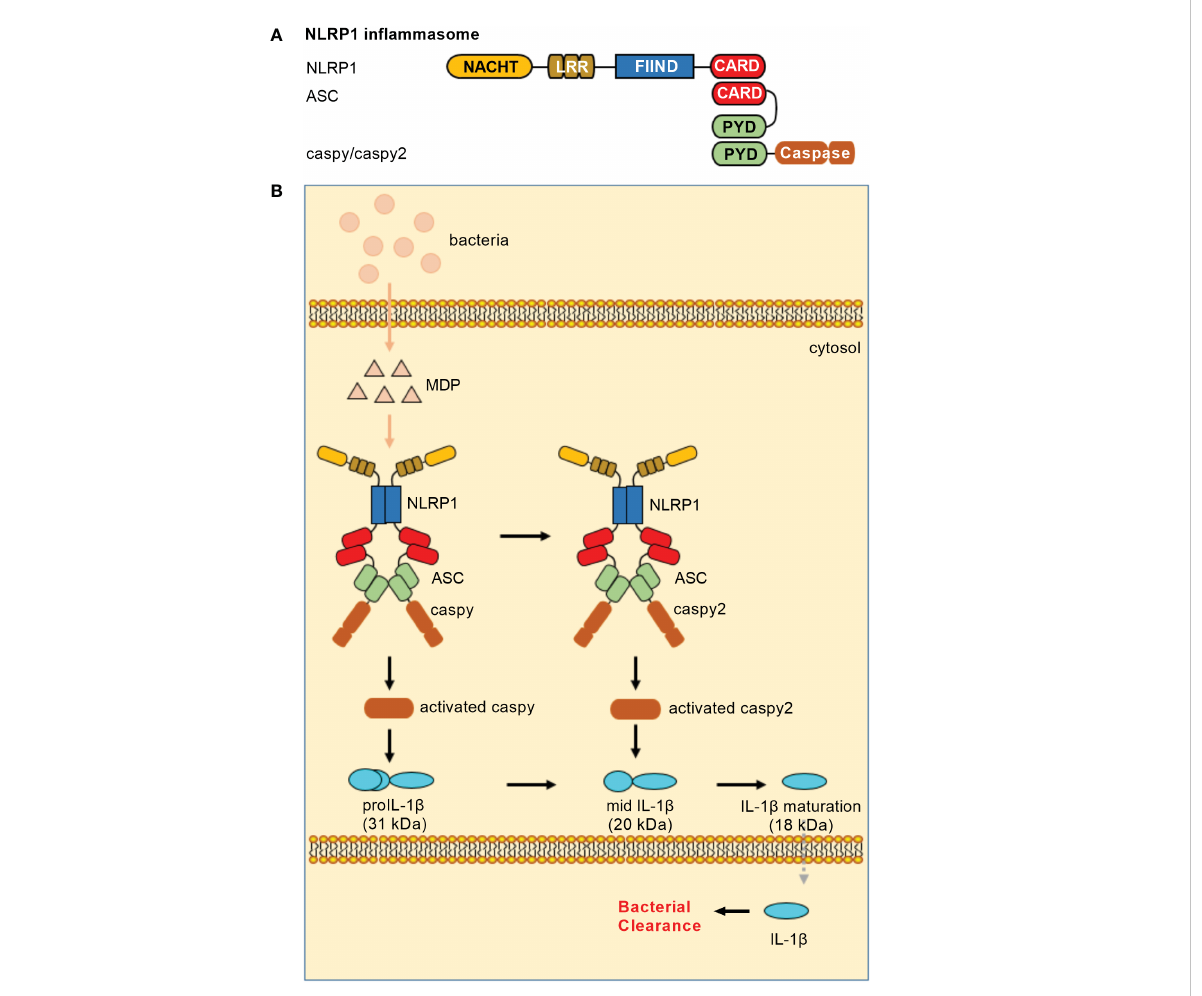
FIGURE 1 NLRP1 in fl ammasomes in teleost fi sh. (A) Minimal NLRP1 in fl ammasomes. Domains: NACHT, nucleotide-binding and oligomerization domain; LRR, leucine-rich repeat; FIIND, domain with function to fi nd; CARD, caspase recruitment domain; PYD, pyrin domain. (B) Activation of the NLRP1 in fl ammasome. Teleost NLRP1 in fl ammasome complex formation was triggered by MDP but not by